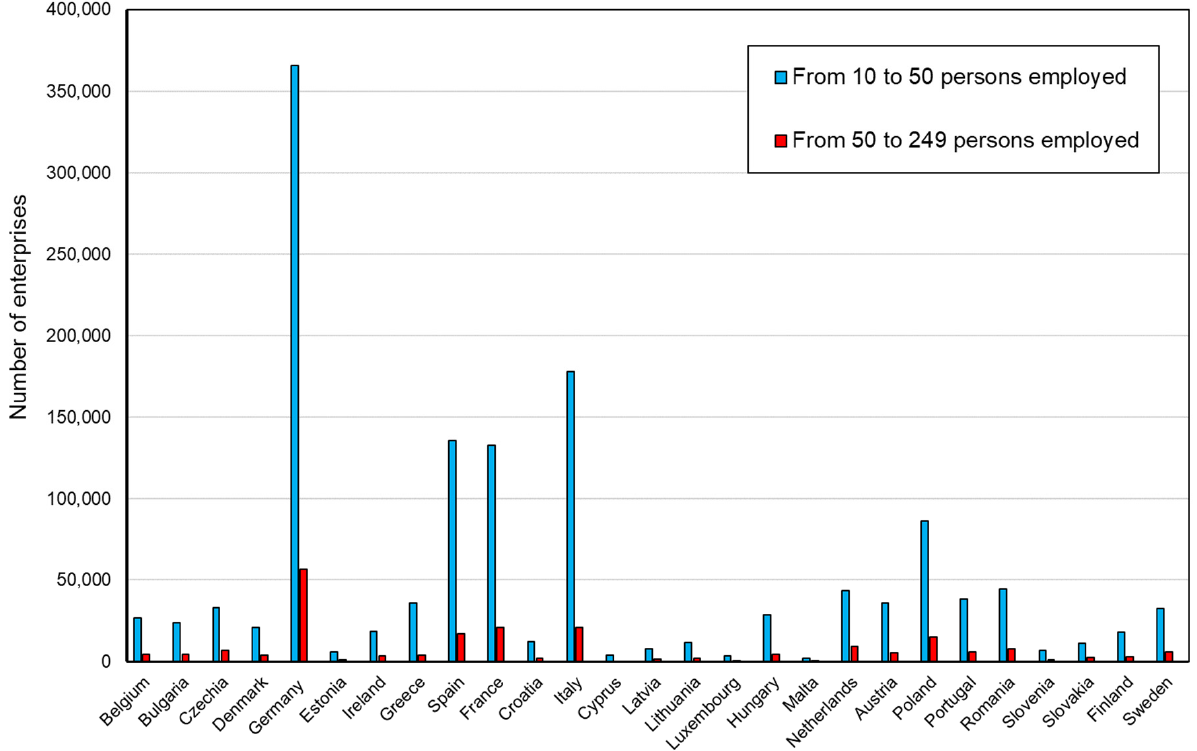
Figure 1. Number of SMEs in EU-27 countries (in 2021).